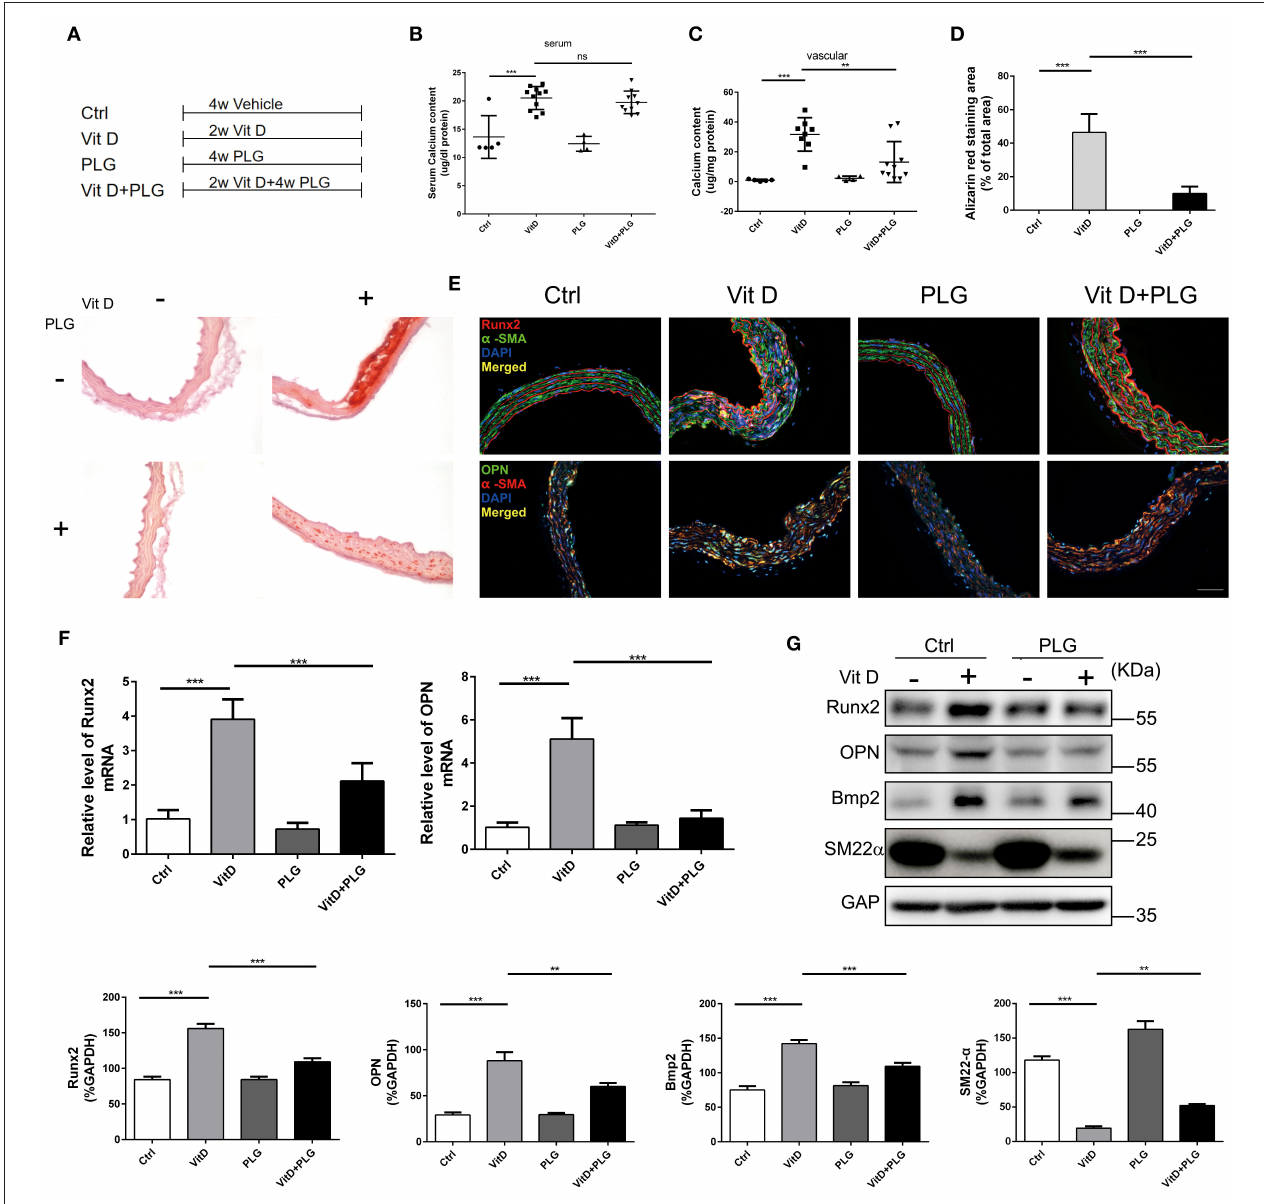
FIGURE 3 | PLG inhibits aortic calcification induced by vitamin D in mice. (A) Four groups of C57BL/6 mice were subjected to the indicated treatments for 4 weeks (Vit D, 8.75 mg/kg/day and PLG, 5 mg/kg body weight every 2 days). (B,C) Serum calcium content and aortic calcium deposition were measured with a QuantiChrom TM calcium assay kit. (D) Calcium deposition was assessed by Alizarin red staining in mouse aortas (scale bars = 20 µ m; n = 6 for each group). The histogram on the right is the quantitative analysis of the Alizarin red-stained areas. (E) Representative images of immunofluorescence staining of Runx2 and OPN in mouse aortas (scale bars = 20 µ m, n = 6 for each group). (F) The mRNA levels of Runx2 and OPN in mouse aortas were measured by qRT-PCR ( n = 6 for each group). (G) The protein levels of Runx2, OPN, Bmp2, and SM22 α in mouse aortas were assessed by western blotting. The relative protein levels were normalized to the level of GAPDH. The data are shown as the mean ± standard error of triplicate sets and are representative of three independent experiments (** P < 0.01, and *** P < 0.001 indicate significant differences between the indicated